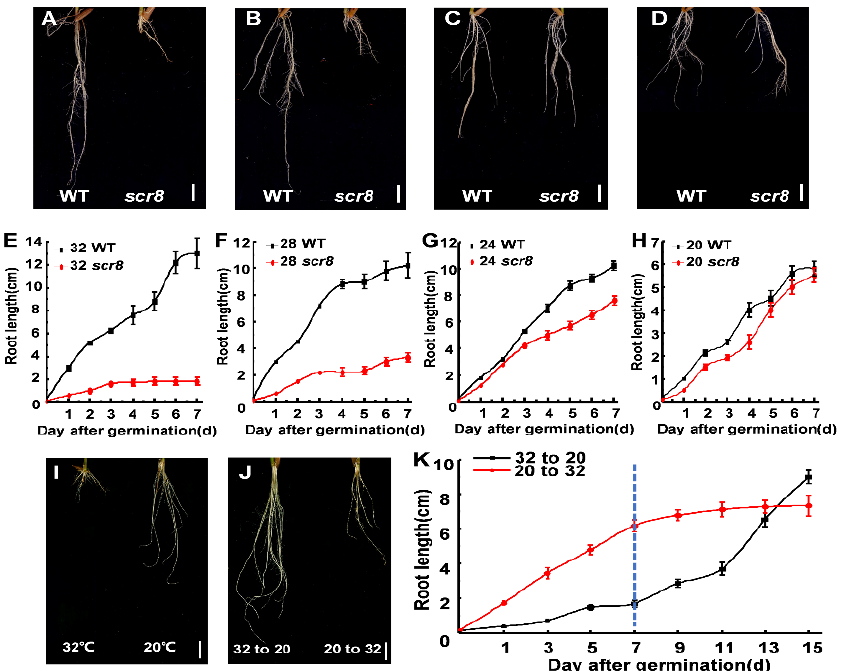
Figure 4. Different temperature treatment and temperature shift experiment. ( A – D ) Morphology of WT and scr8 under various temperature conditions: 32 ◦ C treatment ( A ), 28 ◦ C treatment ( B ), 24 ◦ C treatment ( C ), 20 ◦ C treatment ( D ). Scale bars, 1 cm. ( E – H ) Time-course measurements of root length in WT and scr8 mutant plants: 32 ◦ C treatment ( E ), 28 ◦ C treatment ( F ), 24 ◦ C treatment ( G ), 20 ◦ C treatment ( H ). ( I , J ) temperature shift experiment of scr8. Root phenotype of scr8 grown at 32 ◦ C and 20 ◦ C ( I ), Root phenotype of scr8 after temperature shift ( J ). Scale bars, 1 cm. “32 to 20” and “20 to 32” indicate that the temperature was changed from 32 ◦ C to 20 ◦ C or from 20 ◦ C to 32 ◦ C at 7 days after germination. ( K ) Time course analysis of root length of in response to temperature-shift treatment.